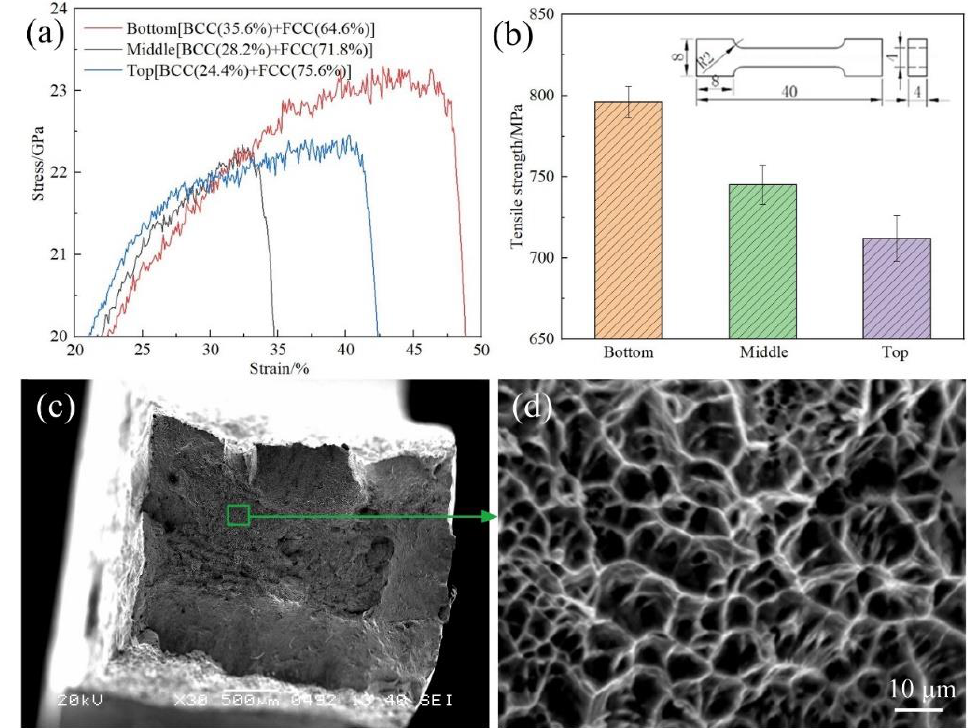
Figure 10. ( a ) Molecular dynamics simulation strain–stress curves different volume ratios of ferrite and austenite; ( b ) variation value of tensile strength in different areas; ( c , d ) typical SEM micrographs of fracture morphology.